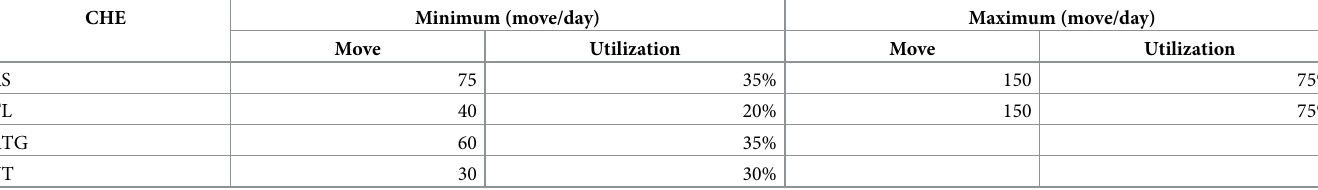
Table 4. Standard CHE usage